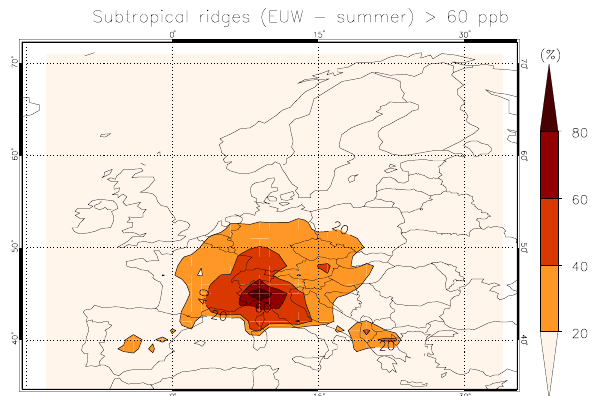
Figure 9. Percentage of summer days with ridge centres within the west flank of the EUR sector (0–15 ◦ E) for which the 60 ppb MDA8 O 3 target is breached. Note the similar geographic location of the region with exceedances on more than 40% of the days in this figure and that where the local 90th percentile is surpassed on more than 30% of the days under this synoptic situation (Fig. 7, upper